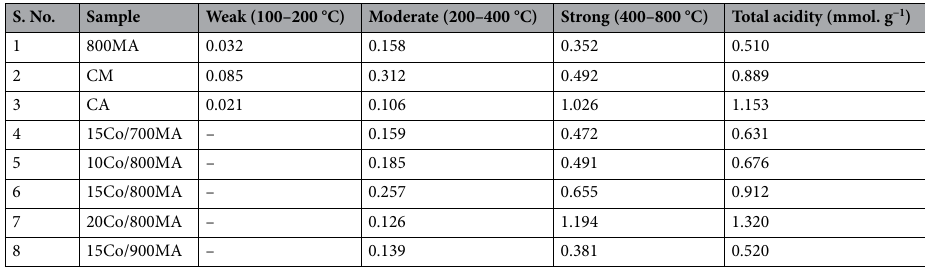
Table 2. NH 3 -TPD analysis of MgAl 2 O 4 (MA), 15Co 3 O 4 /γ-Al 2 O 3 (CA), 15Co 3 O 4 /MgO (CM), and Co 3 O 4 / MgAl 2 O 4 (Co/MA) samples.